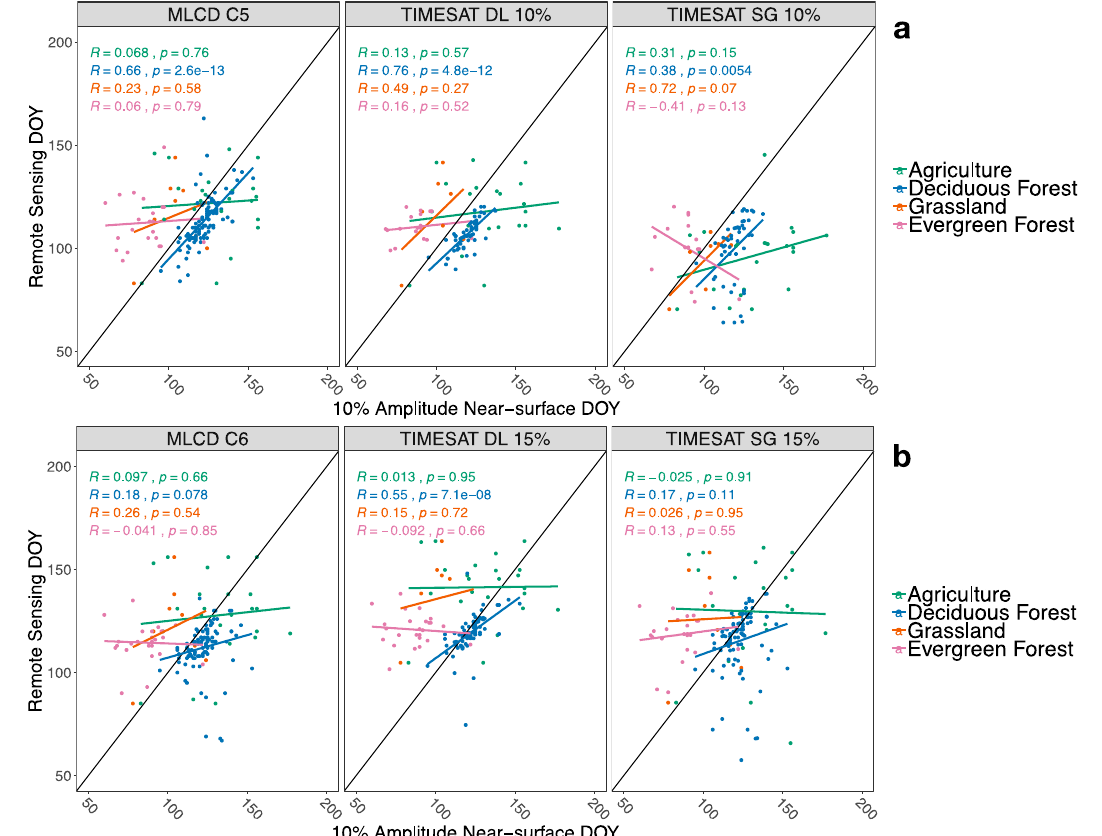
Figure 6. Relationships between Phenocam and MODIS start of season (SOS). Top row ( a ) shows a comparison of PhenoCam dates against C5 MLCD dates, and TIMESAT double logistic (DL) and TIMESAT Savitzky–Golay (SG) results derived from C5 NBAR time series. Bottom row ( b ) shows comparison of Phenocam dates with MLCD C6 dates, and TIMESAT results derived from C6 NBAR time series. Solid black lines show 1:1 relationship and solid colored lines show best fit regression models for the four different land cover classes in the field of view of the cameras.